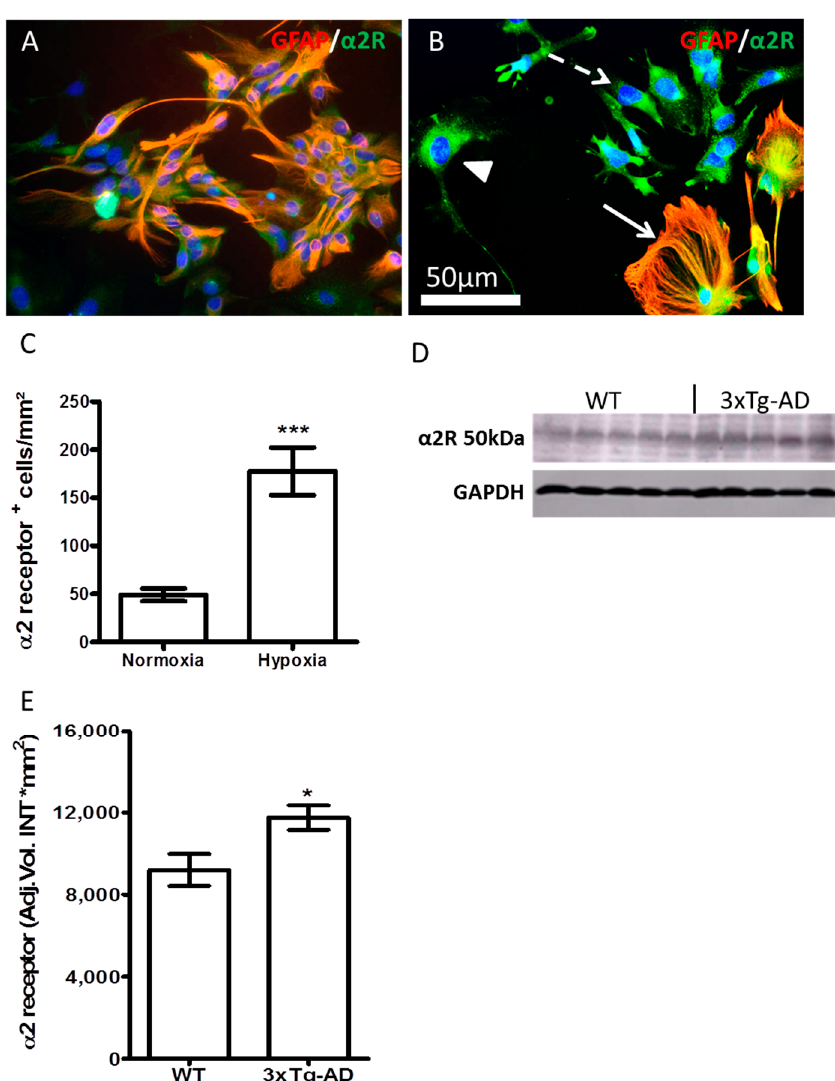
Figure 7. Increased expression of α 2 receptor upon hypoxia and AD-like culture condition. ( A ) APC (DIV7) from the brains of new born C57BL/6 stained for GFAP (red) and α 2 receptor (green); ( B ) Increased α 2 receptor (green) in GFAP+ (red) astroglia (arrow), neurons (arrowhead), and fibroblast-like progenitors (dashed arrow) upon hypoxia; ( C ) Quantification of α 2 receptor-positive cells in DIV7 APC from the brains of C57BL/6 newborn mice. ( D ) Western blot analysis of α 2 receptor ( α 2R) from the brain homogenates of 14-month-old 3 × Tg-AD and wild type (WT) C57/BL6 mice. ( E ) Densitometric analysis of ( D ). Data are presented as mean ± SEM ( n = 5) and analyzed by Student’s t -test. * p < 0.05; *** p < 0.001. Scale bar in ( B ) is 50 µm.